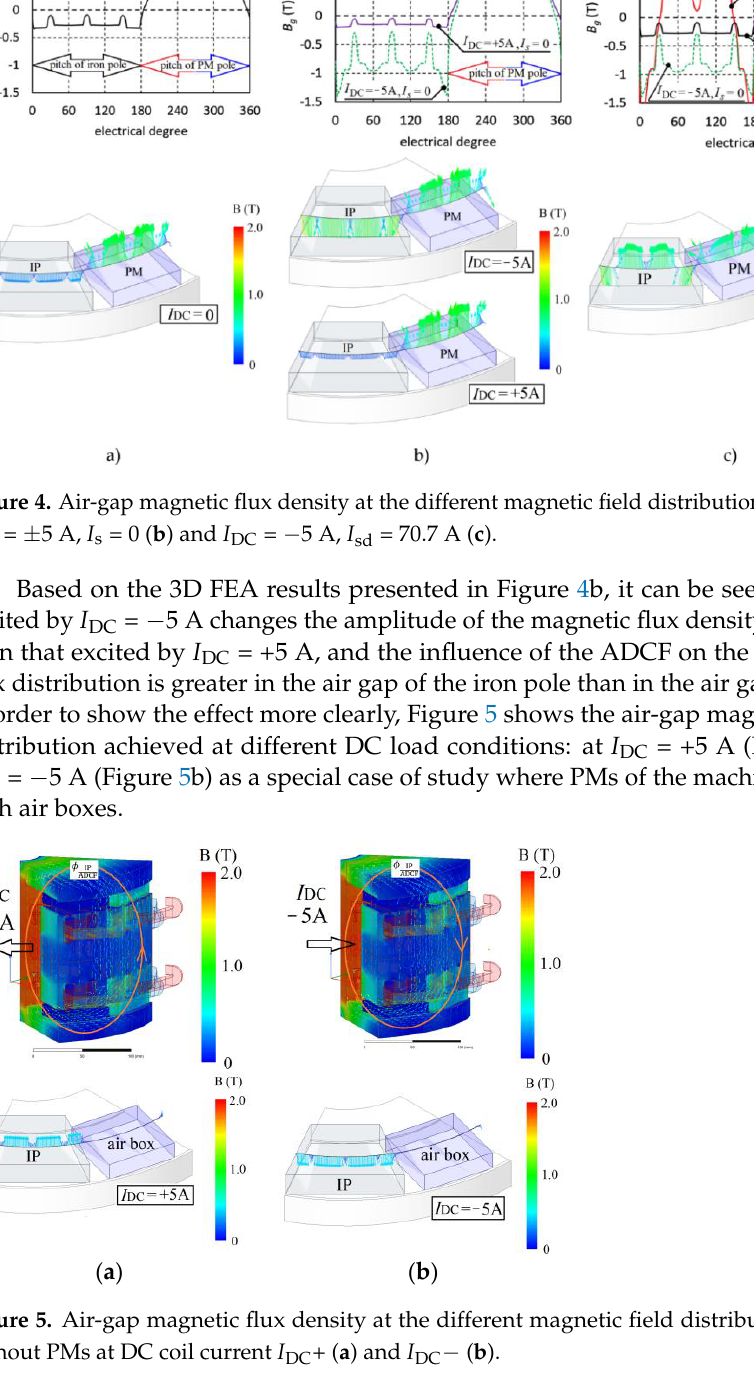
Figure 5. Air-gap magnetic flux density at the different magnetic field distributions in the model without PMs at DC coil current I DC + ( a ) and I DC − ( b ).